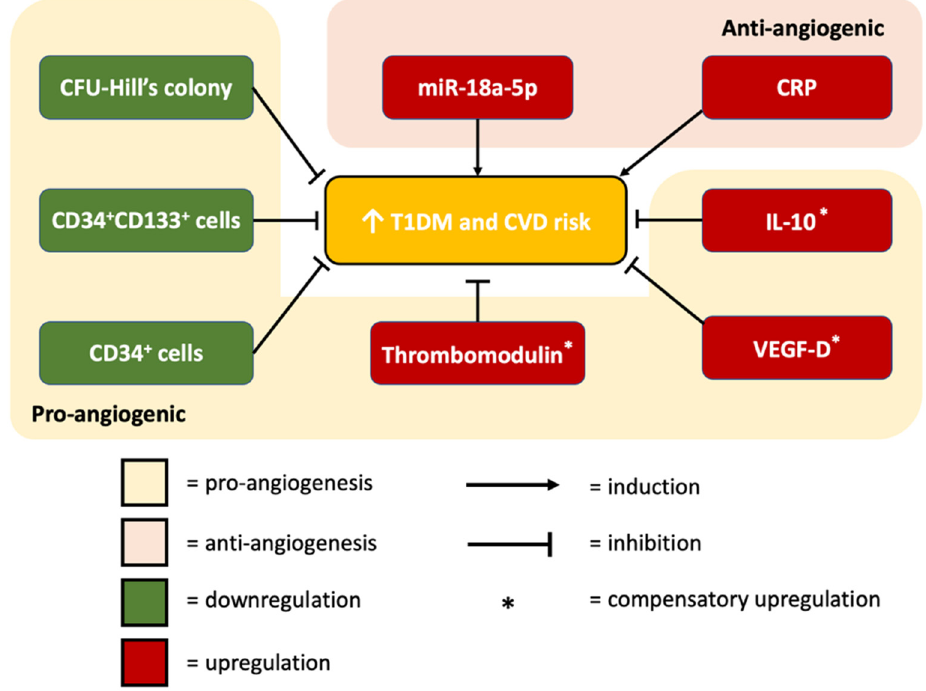
Figure 7. Summary of our study results in patients with subclinical CVD. The upregulated miR-18a-5p and CRP contributed to increased cardiovascular risks in T1DM patients, whereas reduced levels of CFU-Hill’s colony, CD34 + cells, and CD34 + CD133 + cells were observed, indicating poor vascular health and repair. Elevated level of thrombomodulin reflected the degree of inflammation and endothelial damage leading to increased CVD risk. Elevated IL-10 and VEGF-D served as compensatory mechanism to counteract inflammatory conditions. Table 2. The predicted consequential pairing of the target region in the transcript and